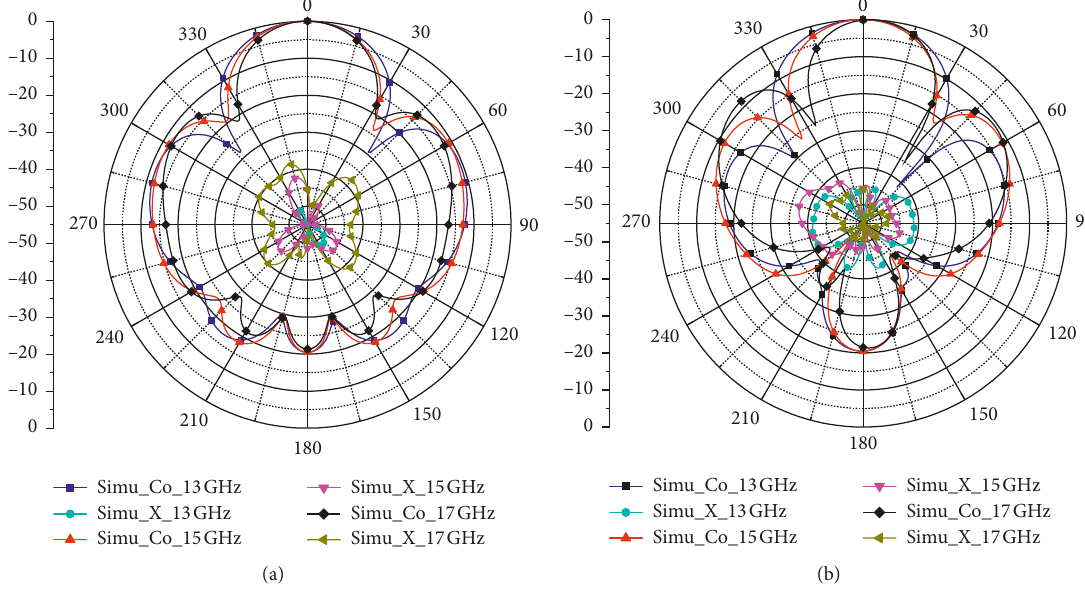
Figure 13: The simulated co- and cross-polarization radiation patterns of the proposed 2 × 2 subarray at 13 GHz, 15 GHz, and 17 GHz on (a) E-plane and (b) H-plane.